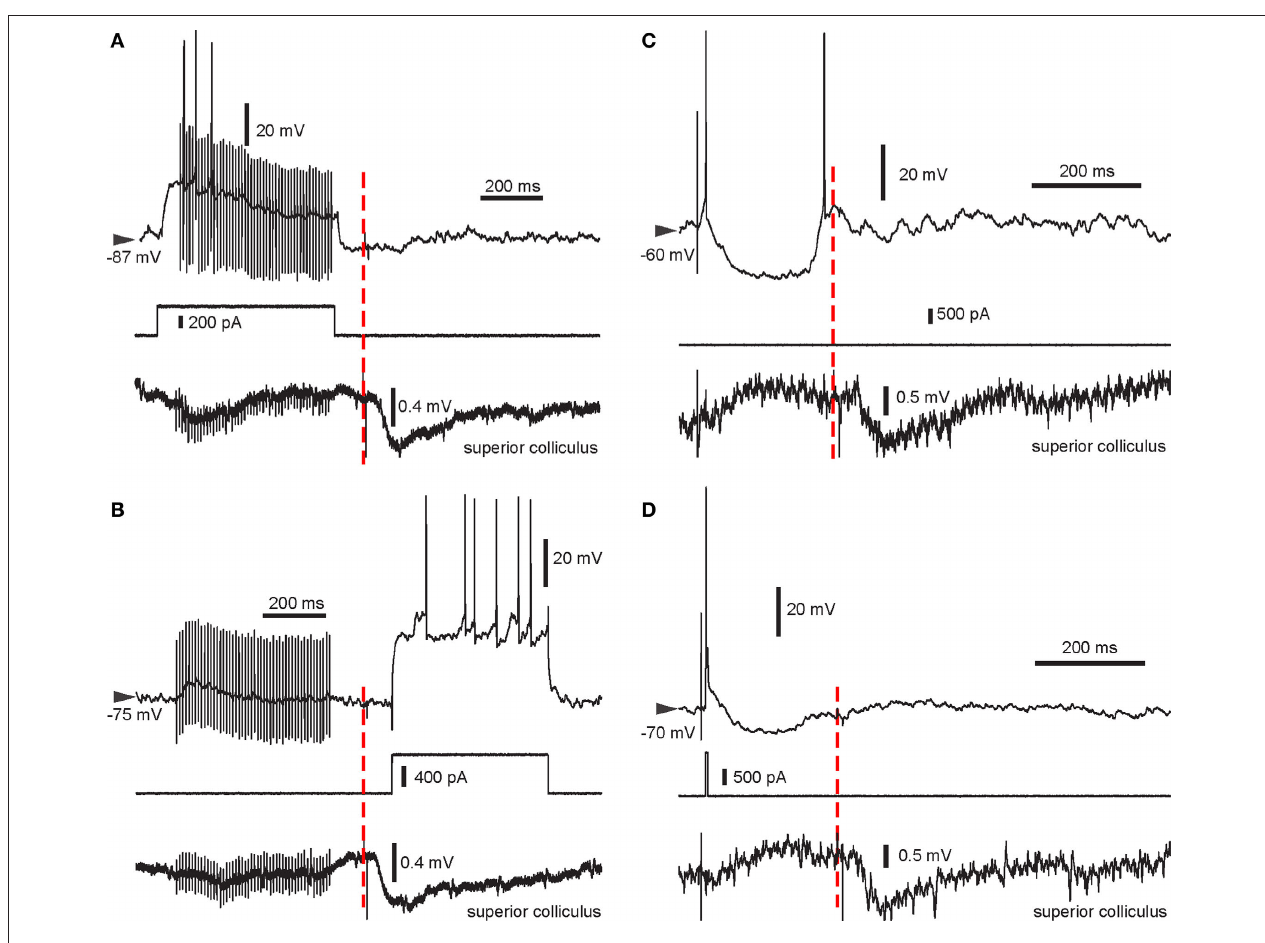
Figure 2 | example traces from all four pairing protocols used. Intracellular recording (top trace), intracellular current injection (middle) and LFP recorded in the SC (bottom) are shown. The start of the light flash is indicated by the red dashed line. Note the negative deflection in the LFP recording indicating